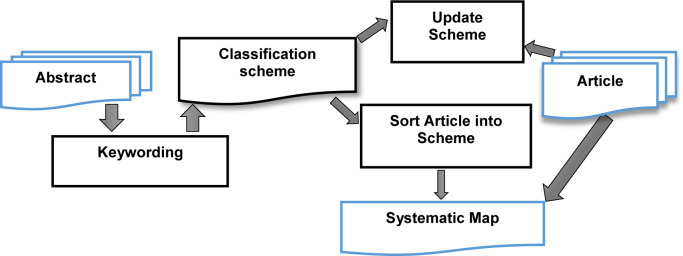
Classification scheme [14].